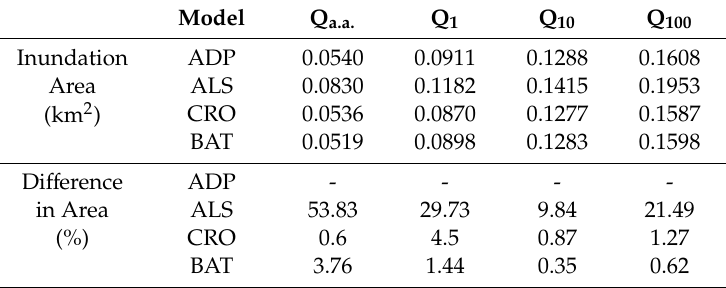
Table 9. Inundation area (IA) di ff erences for compared